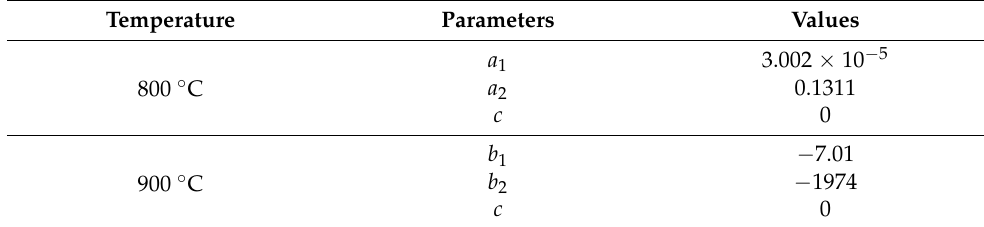
Table 2. The determined angle equation parameters.